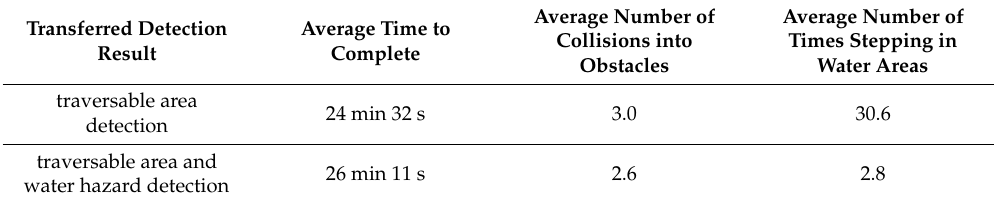
Table 2. Average time, number of collisions and number of times stepping in water areas in two conditions: the stereo sound interface transferred to the participants is generated according to the traversable area detection result with/without water hazard detection.